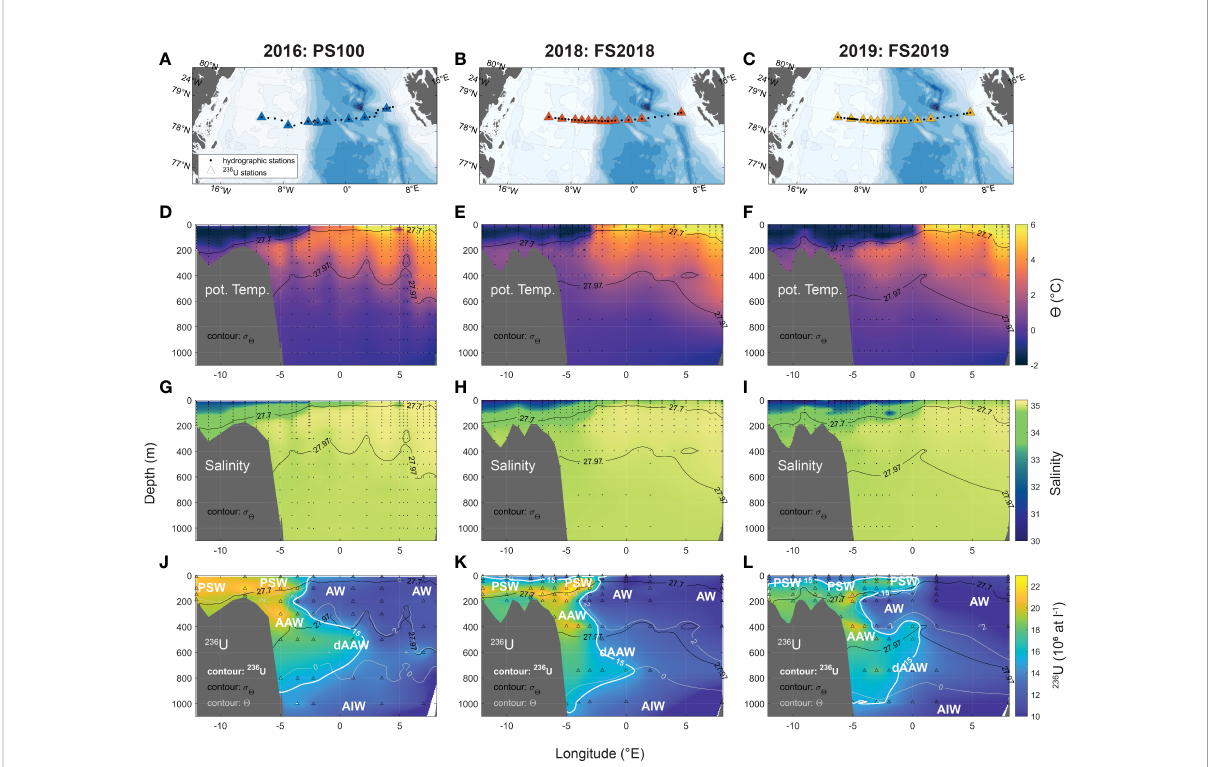
FIGURE 3 (A – C) CTD stations for hydrographic sampling (black dots) and 236 U sampling (colored triangles) during expedition PS100 in 2016 (A) , FS2018 (B) , and FS2019 (C) . (D – F) Transects of potential temperature ( Q ) for 2016 (D) , 2018 (E) , and 2019 (F) . (G – I) Transects of salinity for 2016 (G) , 2018 (H) , and 2019 (I) . (J – L) Transects of 236 U/ 238 U for 2016 (J) , 2018 (K) , and 2019 (L) . In all transects, only the upper 1000 m are shown and bathymetry corresponds to bottom depths of all CTD stations along the transect. Isopycnals of 27.7 and 27.97 are shown in black. In 236 U transects, additionally 236 U isolines of 15 × 10 6 at · L − 1 are shown in white (bold), Q isolines of 0 °C and 2 °C are shown in light gray, and water masses are indicated. PSW: Polar Surface Water, AW: Atlantic Water, (d)AAW: (dense) Arctic Atlantic Water, AIW: Arctic Intermediate